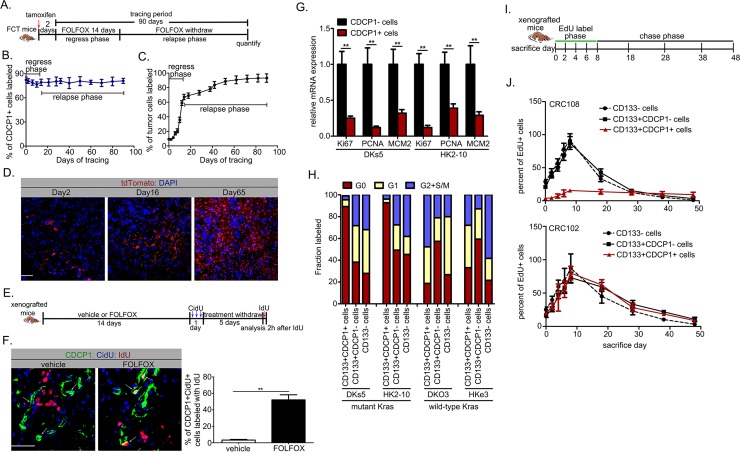
Quiescent CDCP1+ CSCs contribute to postchemotherapeutic recurrence in muKras CRCs.(A) Design for lineage tracing experiments. FCT mice (n = 55) received 5 mg tamoxifen 48 h prior to FOLFOX administration, after which tumor regression and relapse were monitored for 90 days. (B) The frequency of tdTomato+ cells also positive for CDCP1 post-tamoxifen injection (n = 3 per time point). (C) Quantification of tdTomato labeling of tumor cells following tamoxifen injection (n = 3 per time point). (D) Representative images of tumor labeling with tdTomato at day 2, 16, and 65 post-tamoxifen injection. (E) Experimental design. NOG mice were randomized to receive FOLFOX (n = 5) or vehicle treatment (n = 5) twice weekly for two weeks when GFP-labeled CRC101 orthotopic xenografts reached approximately 250 units under intravital imaging. Mice received 3 CidU injections (at 2 h interval) on day 1 after FOLFOX or vehicle treatment. Five days later, mice received IdU 2 h before being killed. (F) Representative images (left panels) and quantification (right panel) of a CDCP1+ CidU+ cell labeled with IdU in tumor sections from Fig 3E. (G) Representative markers for proliferation were examined at the mRNA level in CDCP1+ and CDCP1– subsets from DKs5 and HK2-10 cells. The experiments were independently repeated three times in triplicate. (H) Cell-cycle distribution of CD133+ CDCP1+, CD133+ CDCP1–, or CD133– fractions from muKras and wtKras CRC cells was determined by combined staining with Hoechst33342 and pyronin Y. The experiments were independently repeated three times in triplicate. (I) Design for EdU label-chase experiments. NOG mice carrying CRC102 or CRC108 orthotopic xenografts (n = 30 per group) were exposed to EdU (0.82 mg/ml in drinking water) for 8 days, followed by a 40-day chase. (J) The frequency of EdU+ cells in CD133+CDCP1+ cells, as well as in CD133+CDCP1– and CD133– subsets, was quantified throughout the label and chase phases (n = 3 per time point). Values shown are mean ± SD. A two-tailed unpaired t test was used to compare experimental groups. **p < 0.05. Bar: 50 μm. Underlying data are available in S1 Data. CD, cluster of differentiation; CDCP1, CUB-domain–containing protein 1; CidU, 5-Chloro-2′-deoxyuridine; CRC, colorectal carcinoma; CSC, cancer stem cell; EdU, 5-ethynyl-2′-deoxyuridine; FCT, Fabpl4X@132-rtTA-3×(IRES-Apc.3374):tet-KrasG12D:CDCP1-creERT2:Rosa26 CAG-loxP-stop-loxP-tdTomato; FOLFOX, folinic acid + fluorouracil + oxaliplatin; GFP, green fluorescent protein; IdU, 5-Iodo-2′-deoxyuridine; Ki67, marker of proliferation Ki-67; Kras, Kirsten rat sarcoma viral oncogene homolog; MCM2, minichromosome maintenance complex component 2; muKras, mutant Kras; NOG, nonobese diabetic (NOD)/Shi-scid Il2rgnull; PCNA, proliferating cell nuclear antigen; td, tandem dimer; wtKras, wild-type Kras.